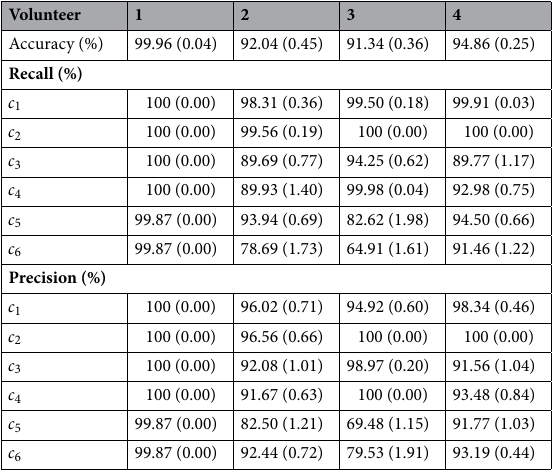
Table 1. Classification results for each